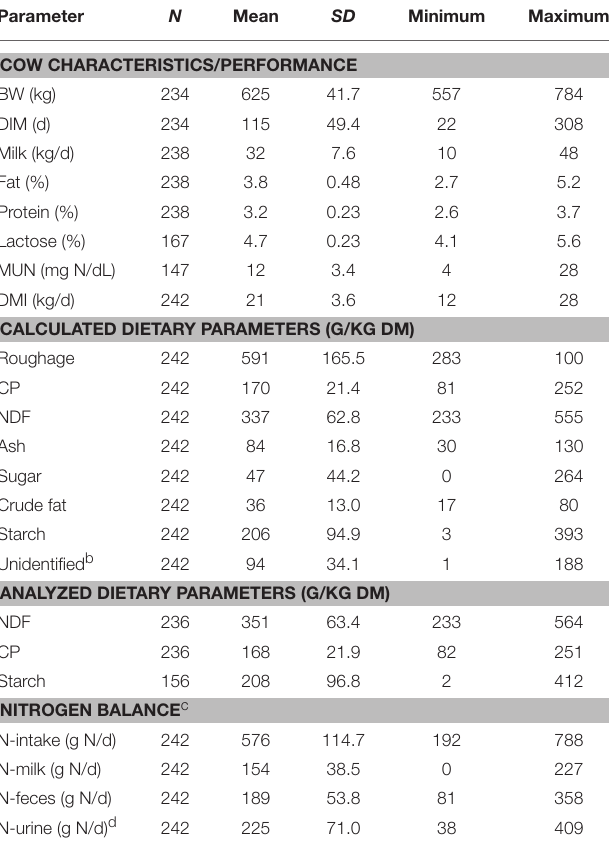
TABLE 1 | Summary statistics of cows and diets in the complete evaluation dataset a . Parameter N Mean SD Minimum Maximum